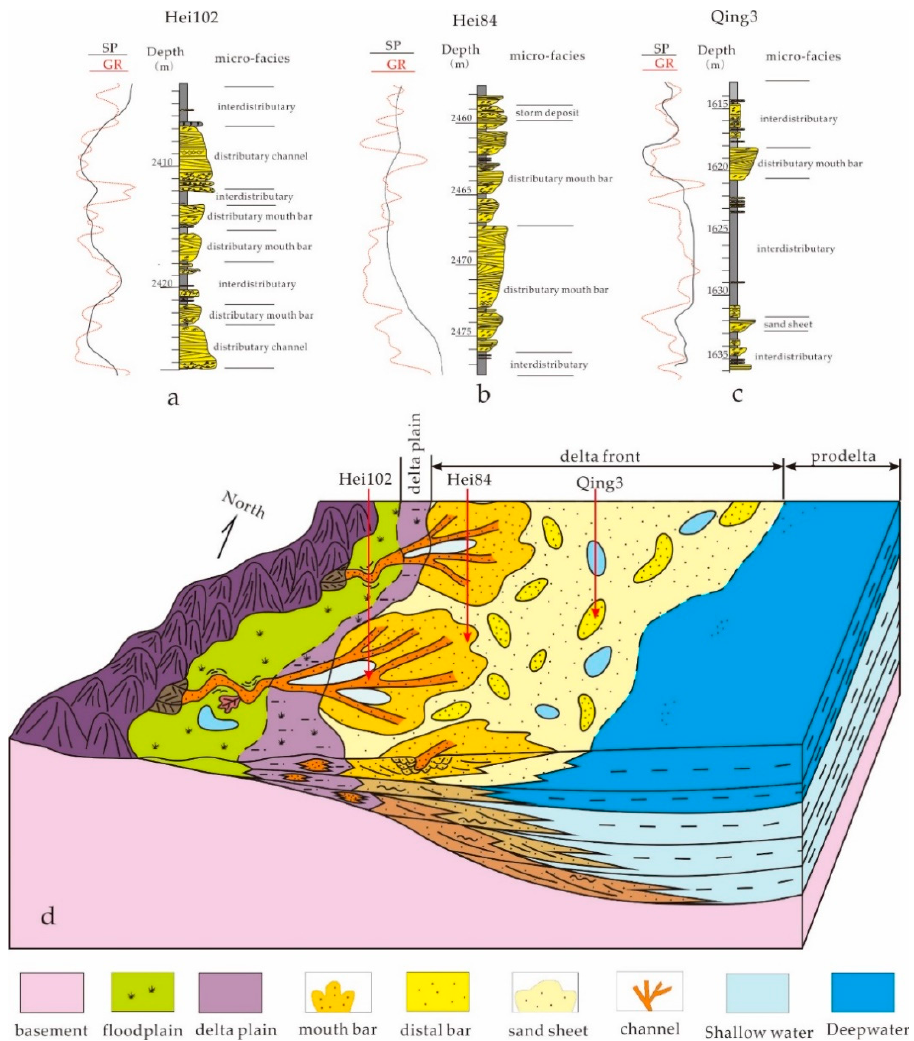
Figure 2. Sediment sequences and models of Daqingzijing Oilfield. ( a ) Single well facies analysis profile of Hei 102, showing the superposition sediments in a near provenance channel and bar sand bodies; ( b ) Single well facies analysis profile of Hei 84, showing the superposition sediments of bar sand bodies; ( c ) Single well facies analysis profile of Qing 3, showing the sand body sediments in argillite; ( d )Highly destructive delta sediment